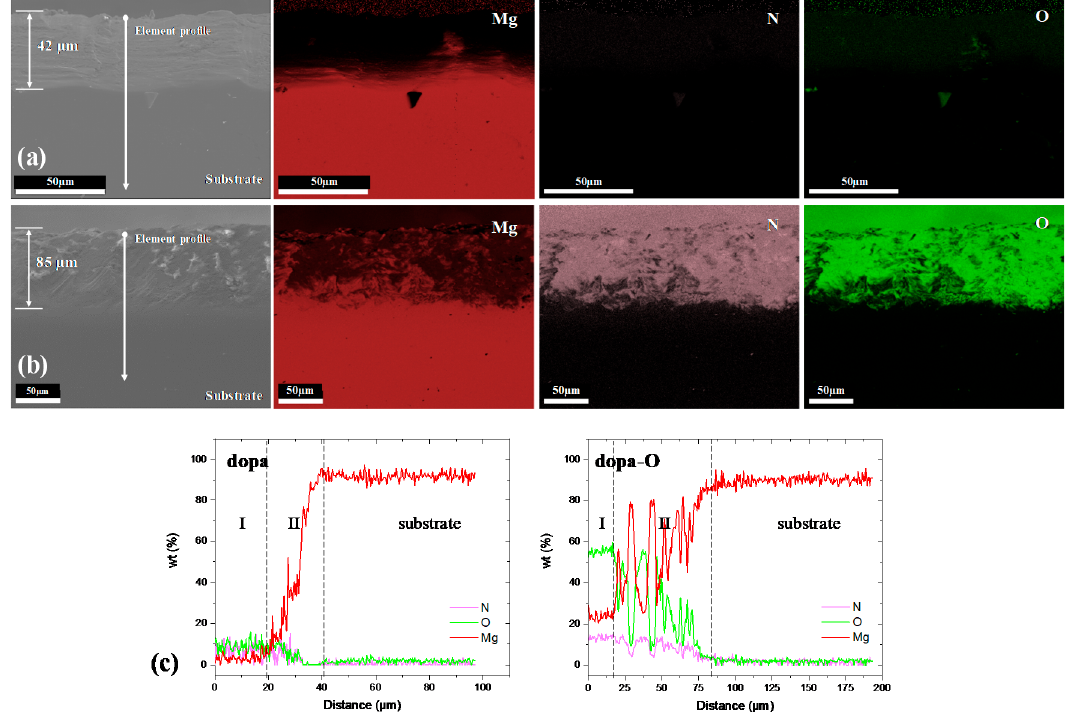
Figure 2. SEM micrographs and relative elemental mapping of the cross section ( a ) “dopa” and ( b ) “dopa-O”; ( c ) elemental line scan of “dopa” and “dopa-O” coatings, marked in the micrographs in ( a ) and ( b ), respectively.